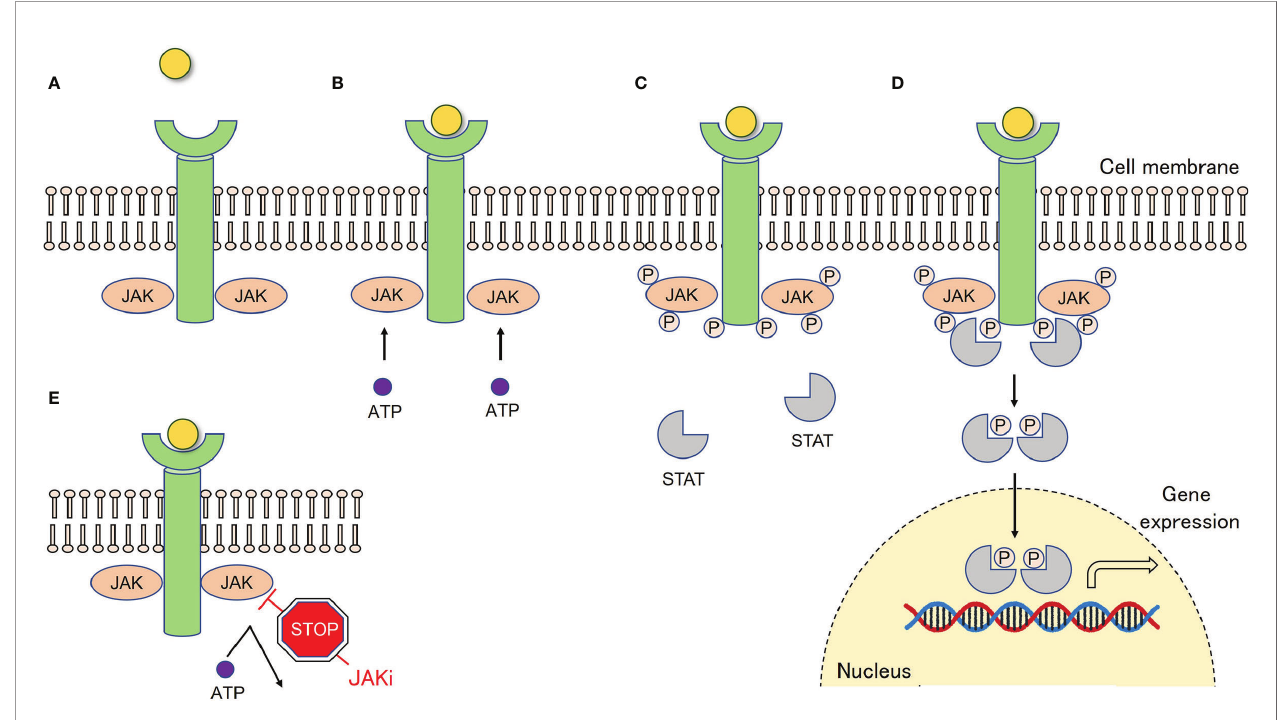
FIGURE 1 | The JAK-STAT pathway and mechanism of action of JAK inhibitors. (A) Type I and type II cytokines utilize the Janus kinase (JAK)-signal transducer and activation of transcription (STAT) pathway. (B) When type I and II cytokines bind to their receptors on the cell surface, JAKs bound to the intracellular domains are phosphorylated by adenosine triphosphate binding. (C) Phosphorylated JAKs, in turn, phosphorylate the receptor end. (D) The transcription factor STAT binds to the receptor end, and phosphorylated STATs form a dimer, which is then transferred to the nucleus to regulate gene expression. (E) JAK inhibitors competitively bind to the binding site of ATP, inhibiting phosphorylation of JAK and exerting their effects. ATP, Adenosine triphosphate; JAK, Janus kinase; JAKi, Janus kinase inhibitor; P, Phosphate; STAT, Signal transducer and activator of